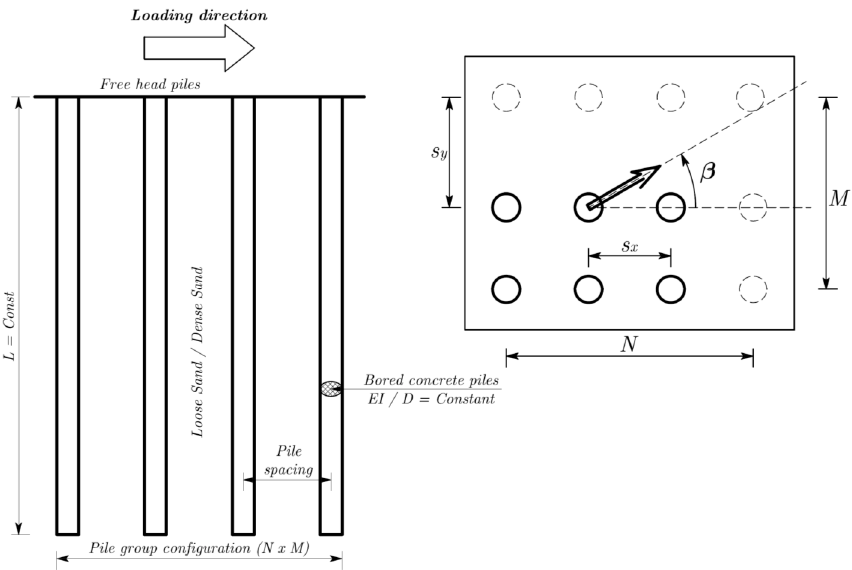
Figure 9. Sketch of the parametric study parameters: left—side view; right—top view; β —angle of direction of lateral loading.